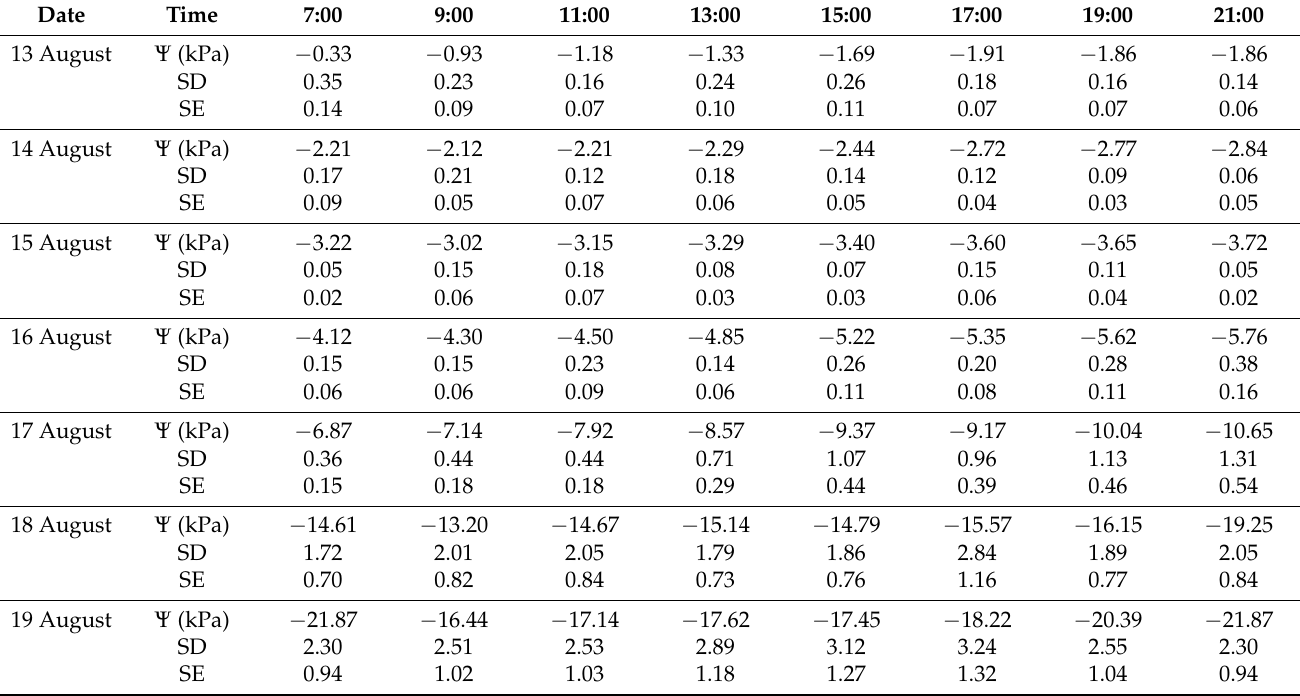
Table 1. The average values and SD/SE of soil water potential ( ψ ) at 0.1 m depth.